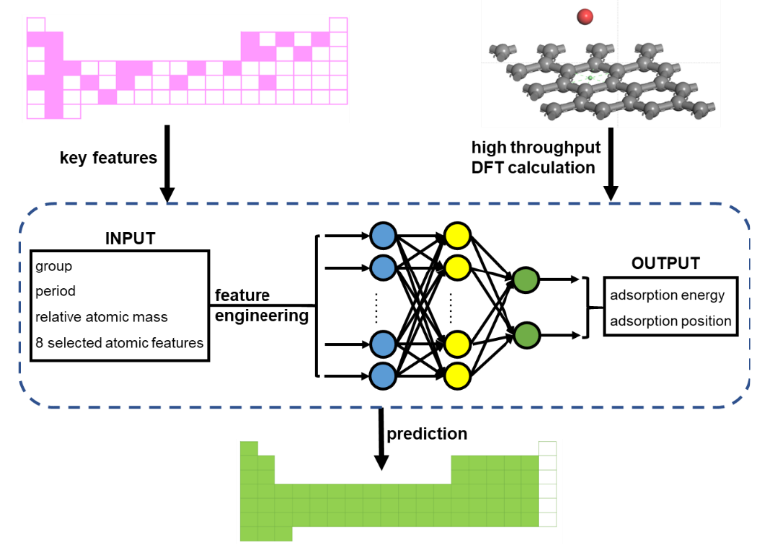
Figure 4. Scheme of the machine learner for the adatom adsorption problem. The workflow utilizes neural networks to accelerate the efficient first-principle calculation of adatom adsorption on graphene. Starting from the DFT calculation of random adatom adsorptions on graphene, the adsorption performances of all the adatoms on the periodic table (except noble gases, lanthanides, and actinides) were predicted using the network shown in the blue box.